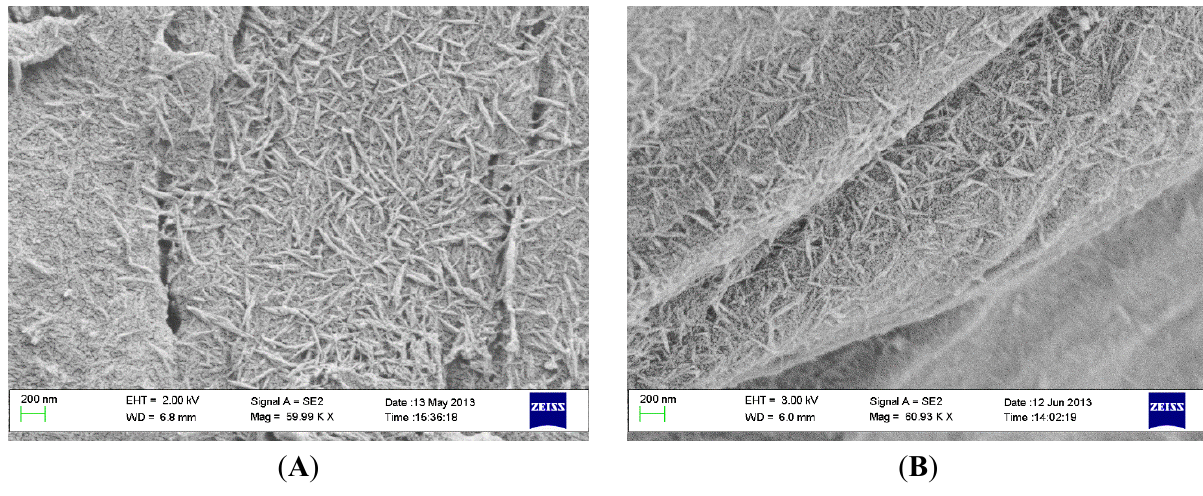
Figure 2. SEM images of a PEEK implant at the thread valleys ( A ) before insertion and ( B ) after insertion and removal. Scale bar = 200 nm.